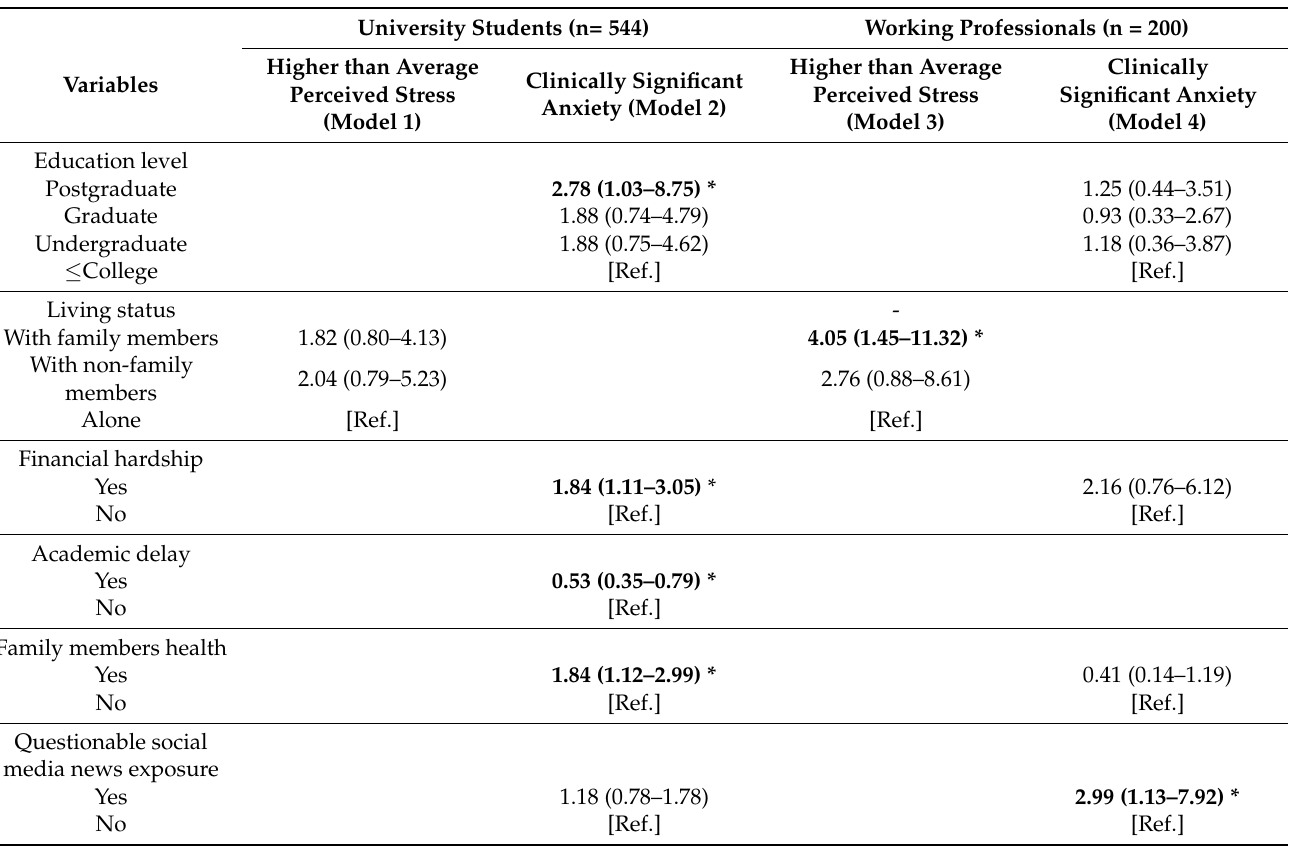
Table 3. Multivariable logistic regression results of associated risk factors of perceived stress and anxiety during COVID-19 lockdown in